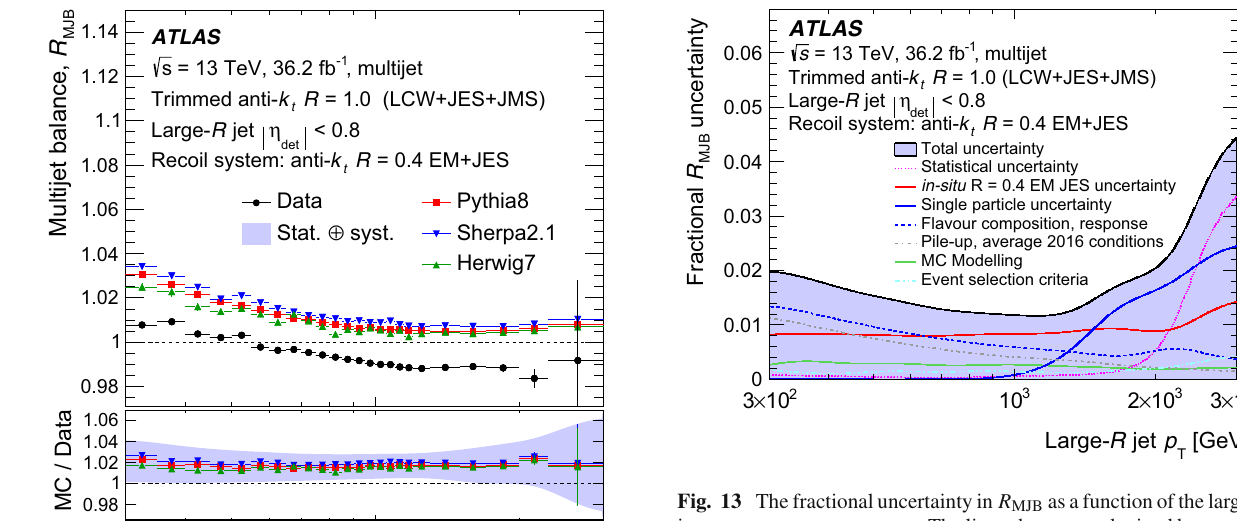
Fig. 13 The fractional uncertainty in R MJB as a function of the large- R jet transverse momentum p T . The lines shown are obtained by